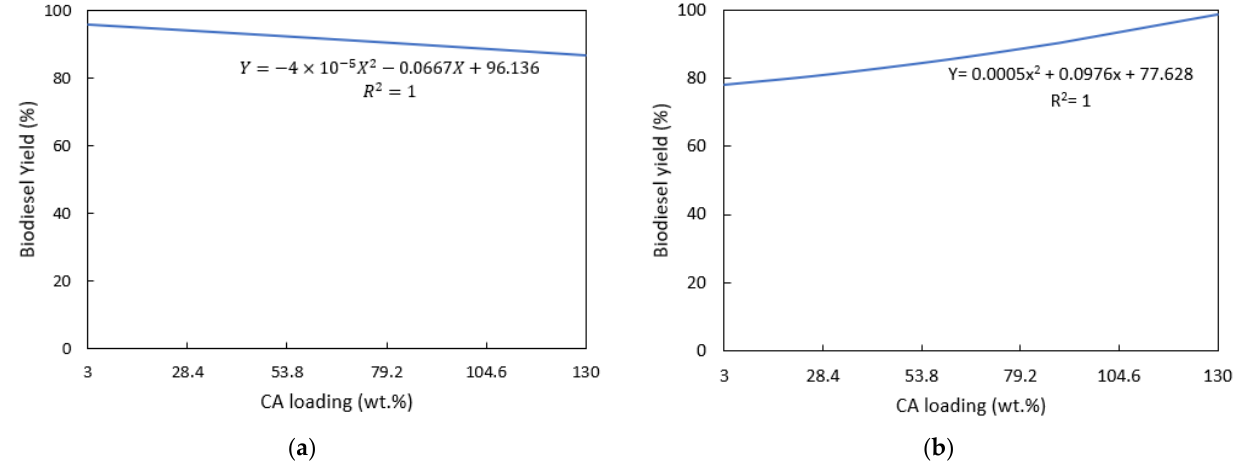
Figure 7. Effects of the citric acid loading wt.% on biodiesel yield: ( a ) CaO/CA; ( b ) NaOH/CA. Synthesizing CaO with citric acid attained a maximum biodiesel yield of 94.25%, ±1.6,